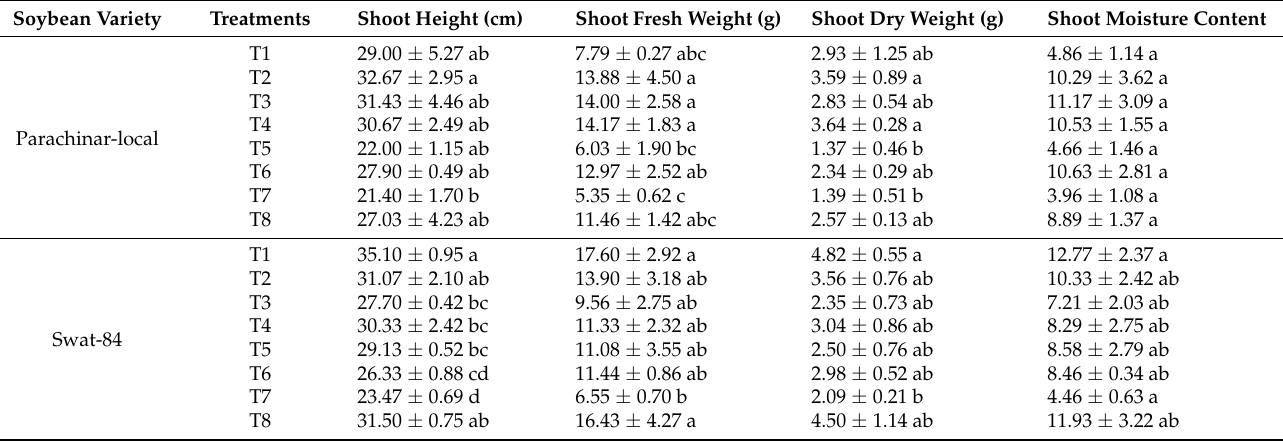
Table 1. Changes in shoot growth of both soybeans.